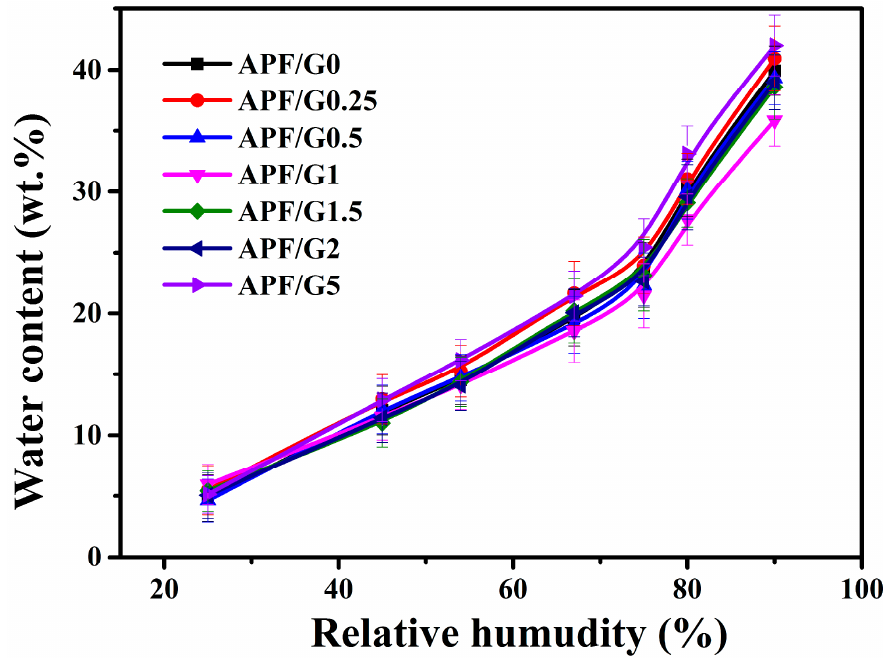
Figure 5. Water vapor sorption isotherms at 25 °C for different blending films. Table 4. Mechanical properties of amylose/PVA blend films under different